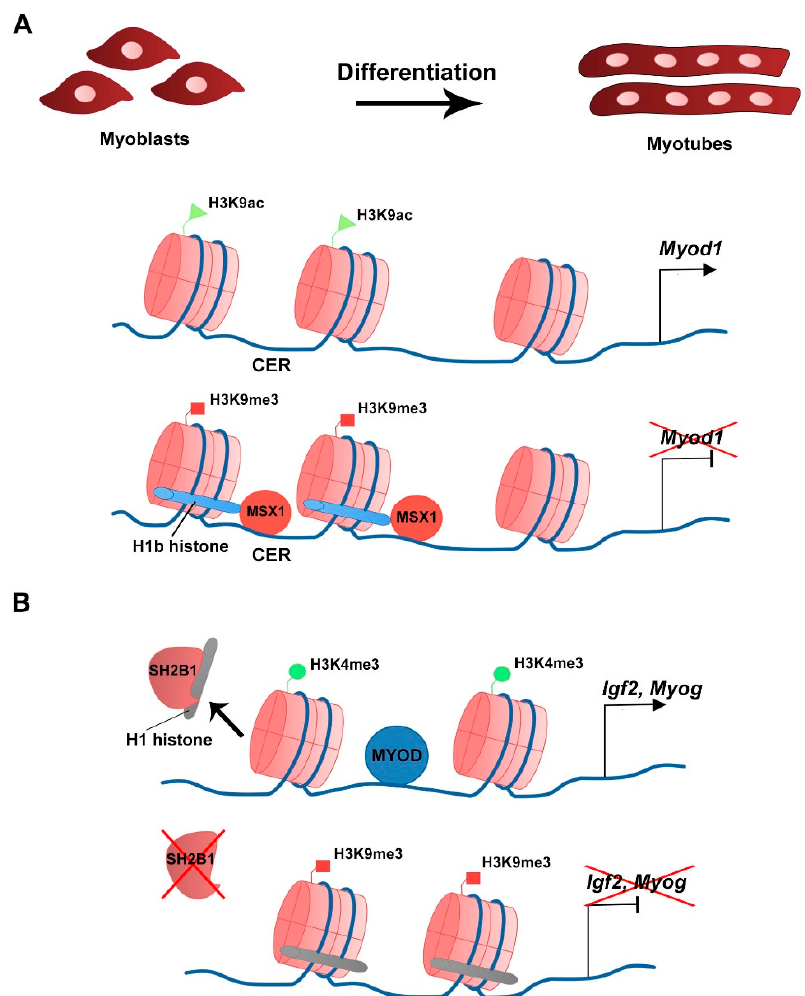
Figure 3. Linker histone H1 variants and myogenic gene expression. ( A ) At the myoblast growth stage Myod1 expression is inhibited by the presence of MSX1 that interacts with the H1 variant H1b at the CER, which correlates with the repressive histone mark H3K9me3 (Lee et al., 2004). ( B ) Upon differentiation, SH2B1 interacts and releases H1 histone variants from the regulatory regions of Igf2 and Myog. Lack of SH2B1 maintains H1 variants in the nucleosome that associate with the repressive mark H3K9me3 (Chen et al., 2017).